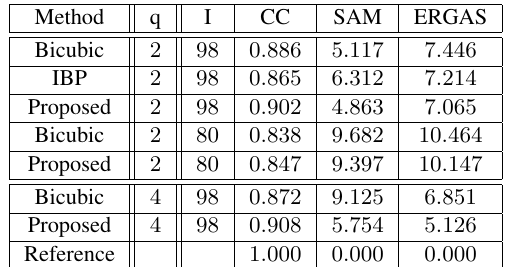
Figure 5: Plot showing de- tailed performance of Corre- lation coefficients for q = 2 of AVIRIS HS bands 1-141